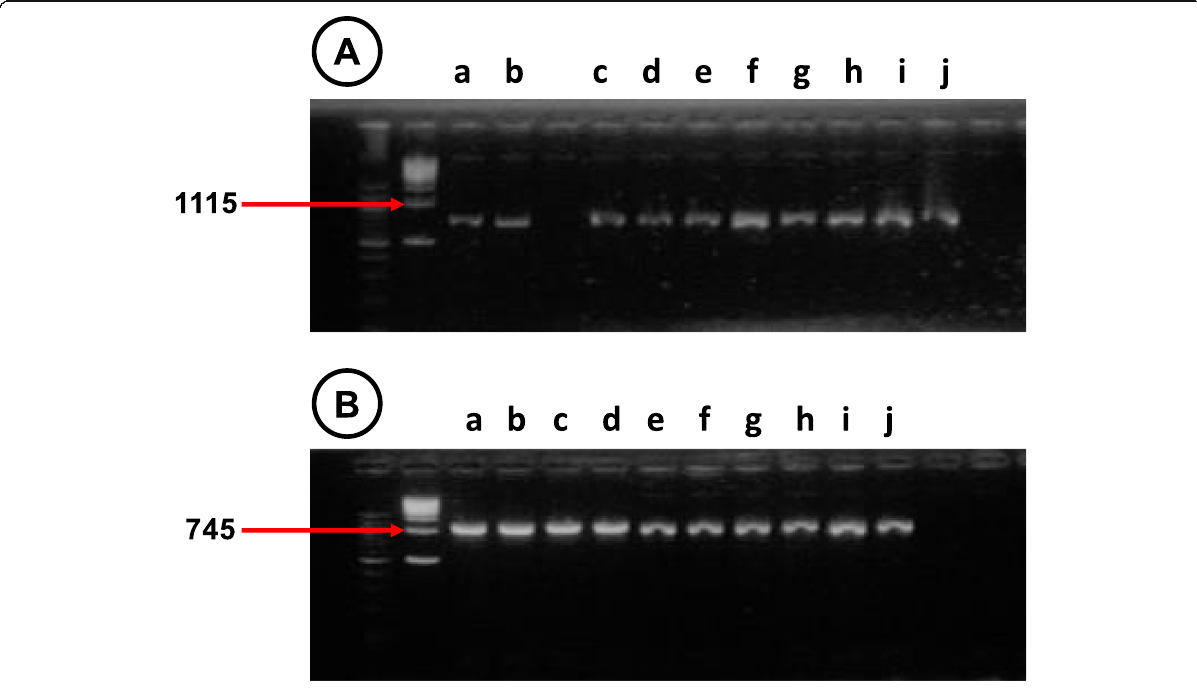
Fig. 2 Conventional PCR of Pseudomonas fluorescens . A DGPf5, B DGPf7